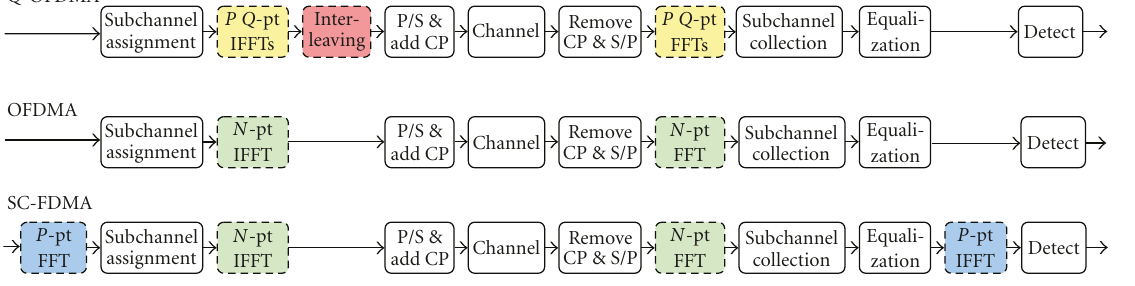
Figure 1: System structure